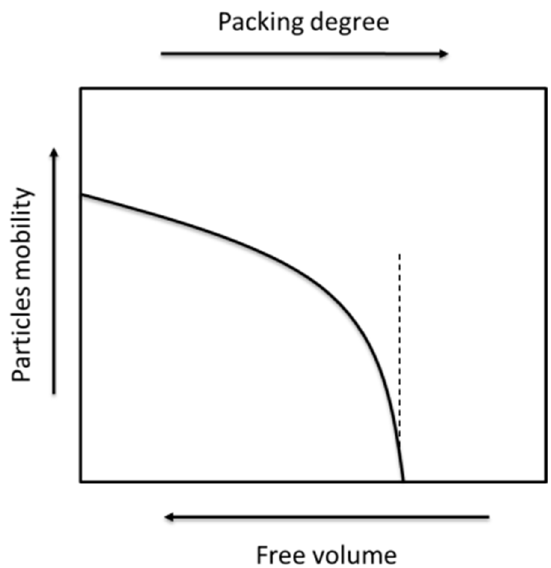
Figure 6. The qualitative free volume concept. adapted from Struik, 1978. An increasing degree of packing entails a decrease in the mobility. At a critical degree of packing, the mobility steeply falls to zero.